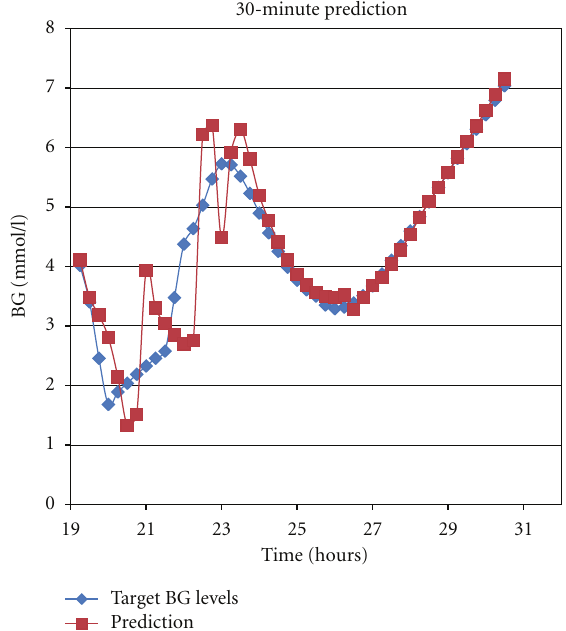
Figure 4: 15-minute prediction results from a day of data not used during AIDA training.